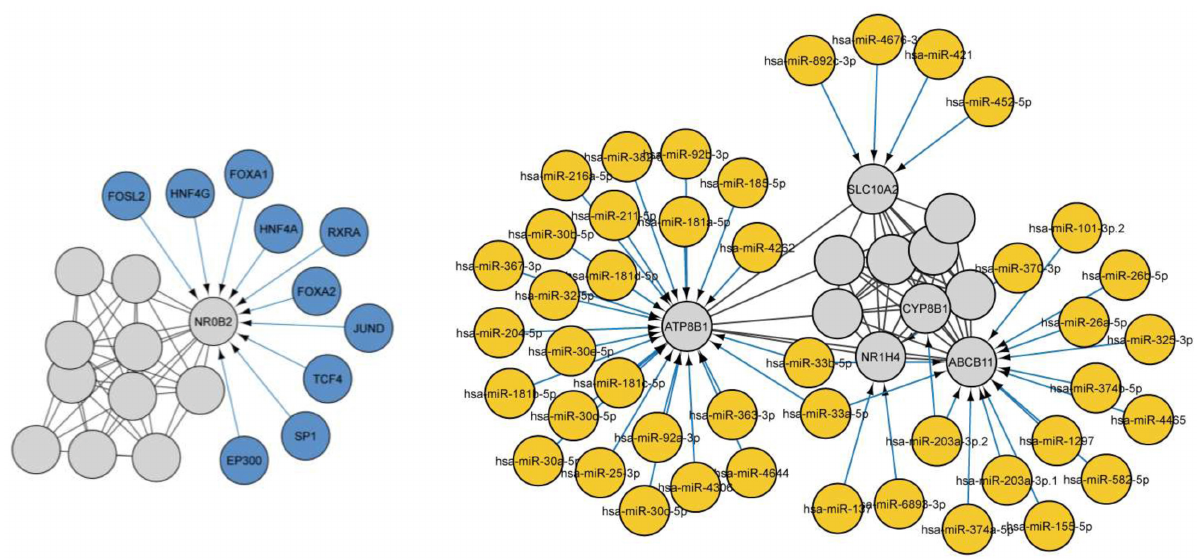
Figure 6. Cytoscape app CyTargetlinker version 4.1.0 was used to screen the transcription factors and microRNAs using ENCODE and Target-scan databases, respectively. In the screen of transcription factors of ABCB11 interaction network we observed 21 nodes and 52 edges. Among these transcription factors, FOXA have been suggested an important factor in bile duct development and lipid accumulation. HNF4A in the regulation dyslipidaemia and terminal liver failure and JUND in fibrosis development. Others can be investigated in future studies. We counted 55 nodes and 89 edges in the search of microRNA targeting the ABCB11 network. Four genes ( ABCB11, ATP8B1, SLC10A2 and NR1H4 ) targeted by multiple microRNAs also some microRNA such as has-miR-203a-3p.2 and has-miR-203a-3p.2 target more than one gene. By nature, a microRNA can regulate several pathways therefore it would be interesting to study in future the dysregulation of these microRNAs and interaction with Identified transcription